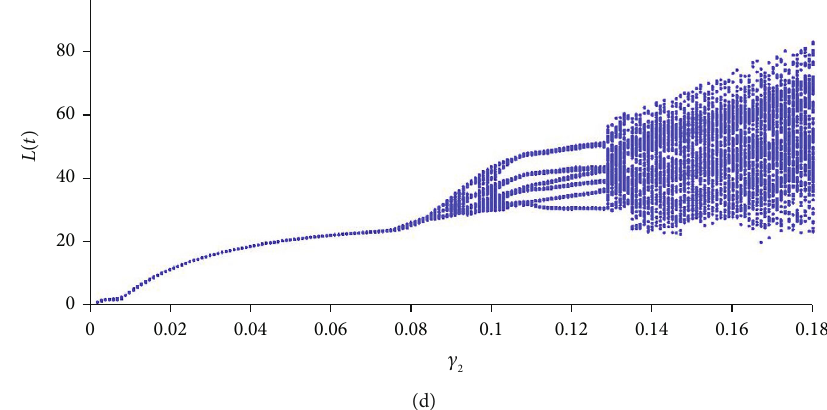
Figure 7: Bifurcation diagram for parameter γ 2 versus (a) nutrients; (b) phytoplankton; (c) zooplankton; and (d) Limnothrissa miodon for model system (1) with assumed initial condition: N ð 0 Þ = 10, P ð 0 Þ = 7, Z ð 0 Þ = 4, L ð 0 Þ = 2, R ð 0 Þ = 0 : 5 using the default parameter values in